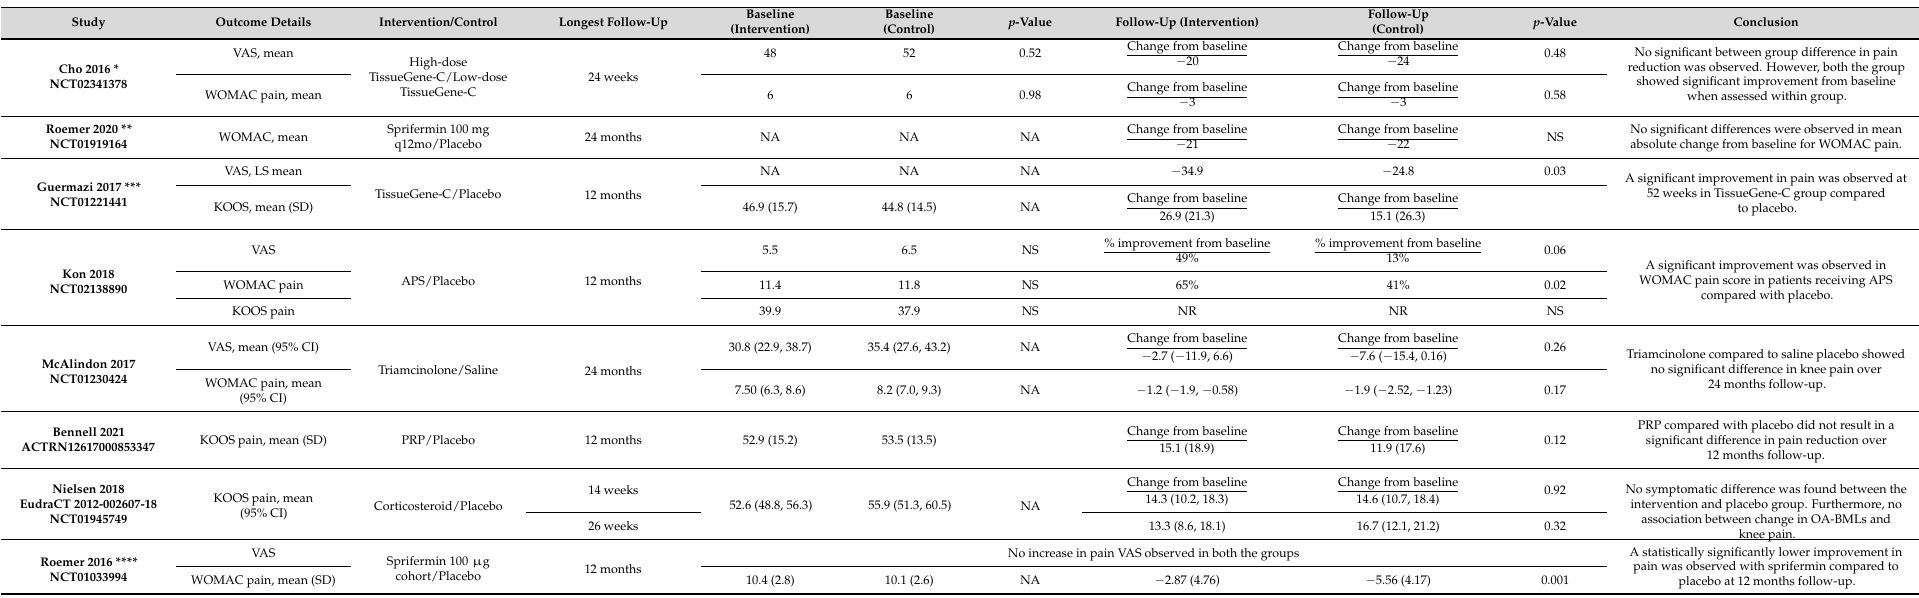
Table 3. Changes in knee pain after treatment at longest reported